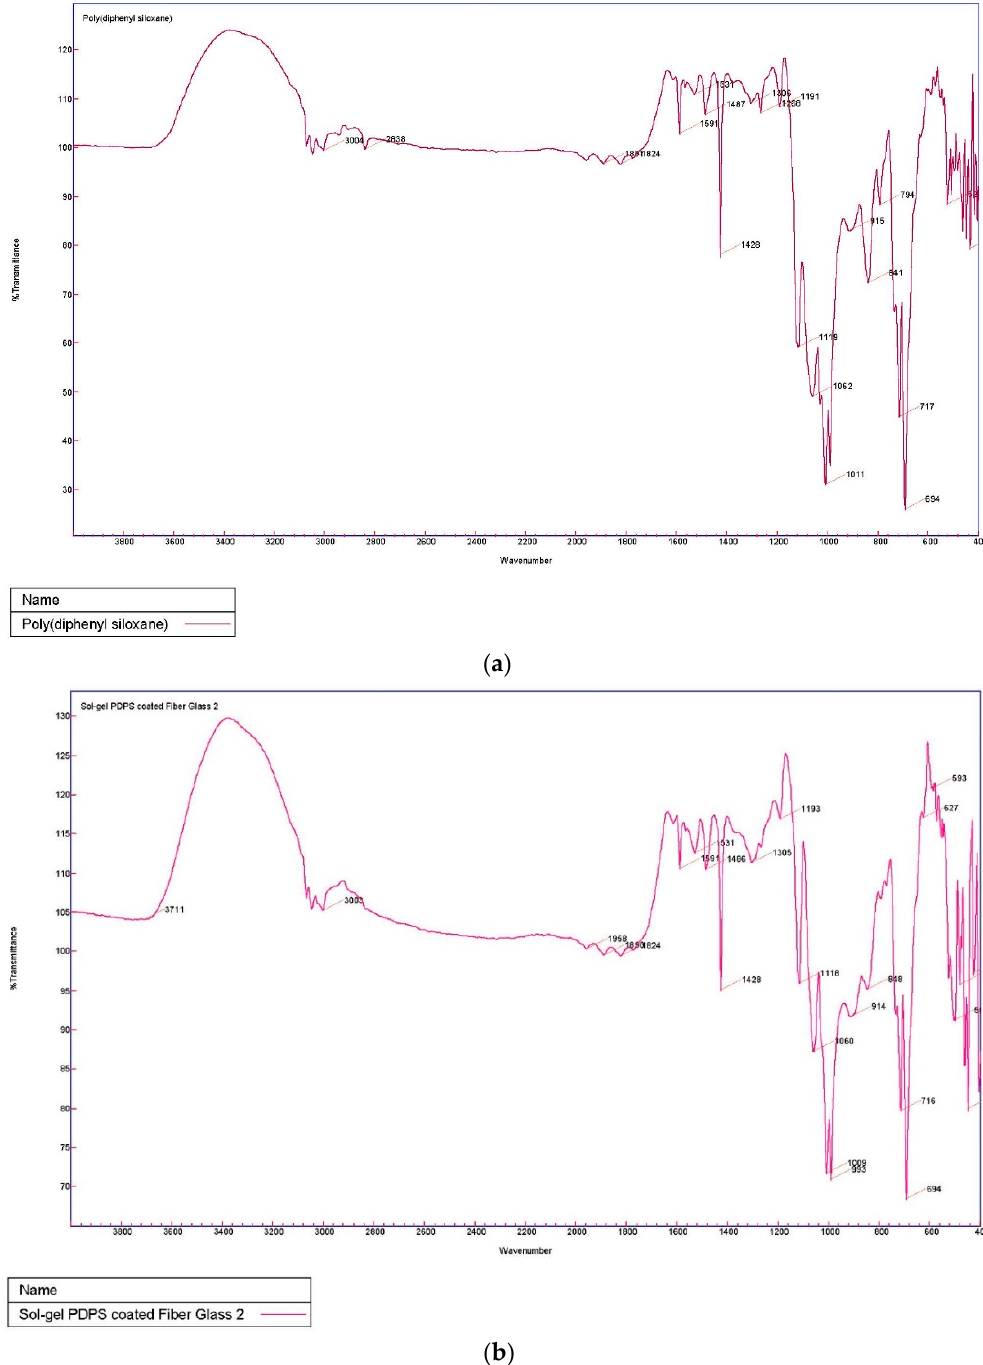
Figure 2. Fourier Transform Infrared Spectroscopy (FT-IR) spectra of ( a ) pristine poly (diphenylsiloxane) (PDPS) polymer and ( b ) sol–gel PDPS coated fiberglass. and ( b ) sol–gel PDPS coated